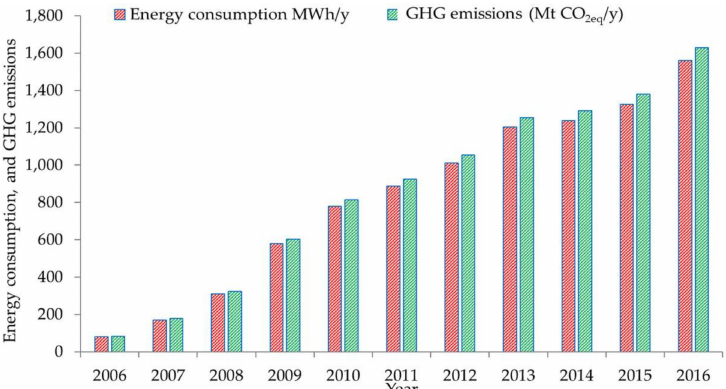
Figure 6. Overall seawater desalination energy consumption and GHG emissions from 2006–2016.